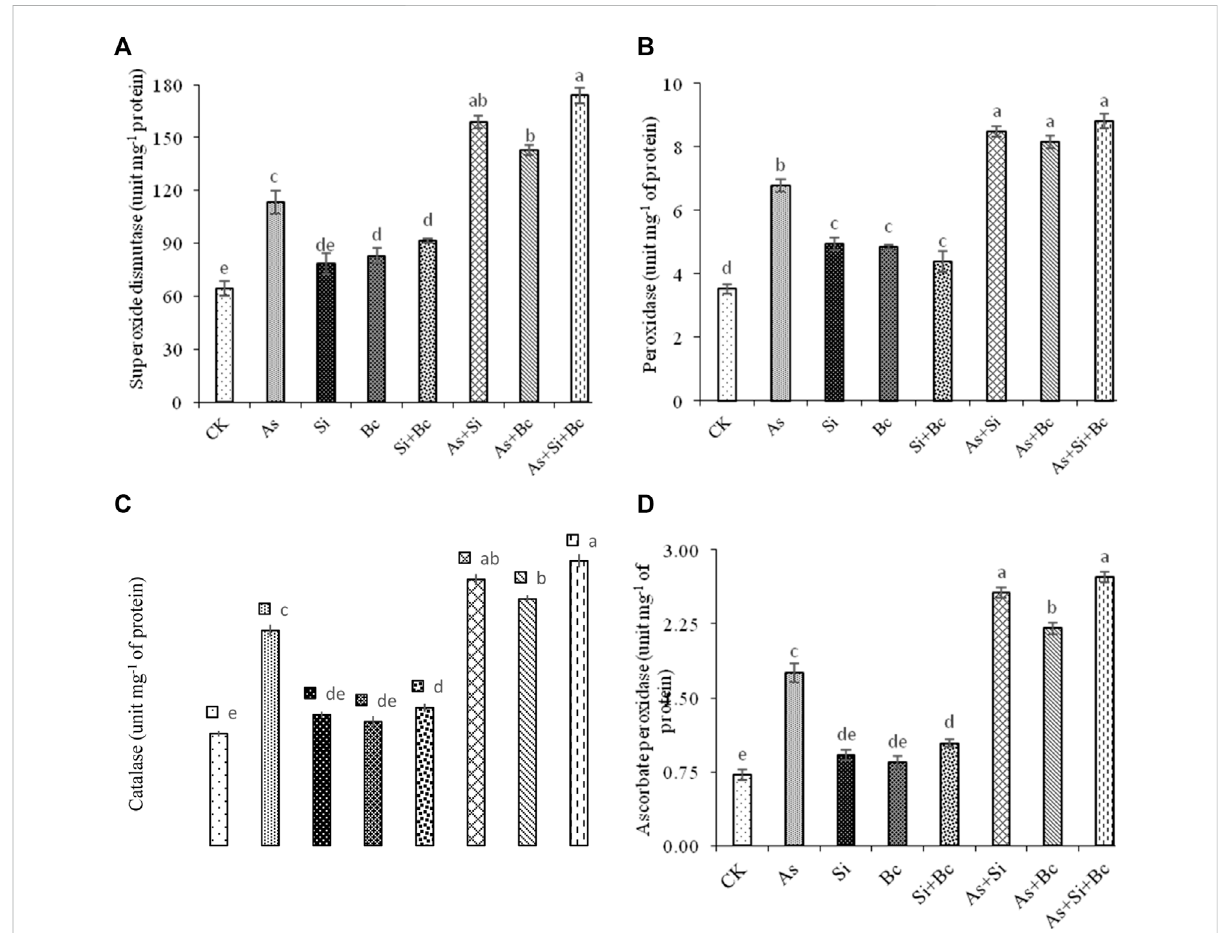
FIGURE 3 Effect of sole and combined application of silicon and biochar on superoxidase dismutase (A) , peroxidase (B) , catalase (C) , and ascorbate peroxidase (D) of maize under As toxicity. Bars sharing the same letter do not have a signi fi cant ( p < 0.05) difference. Error bars show the standard error of